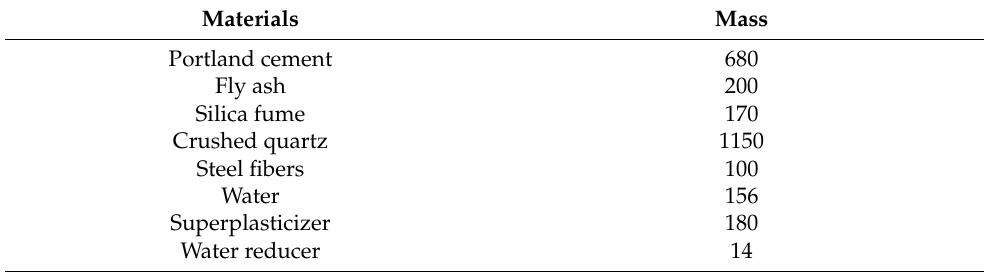
Table 1. Ultra-high performance concrete (UHPC) mixture (kg/m 3 ).